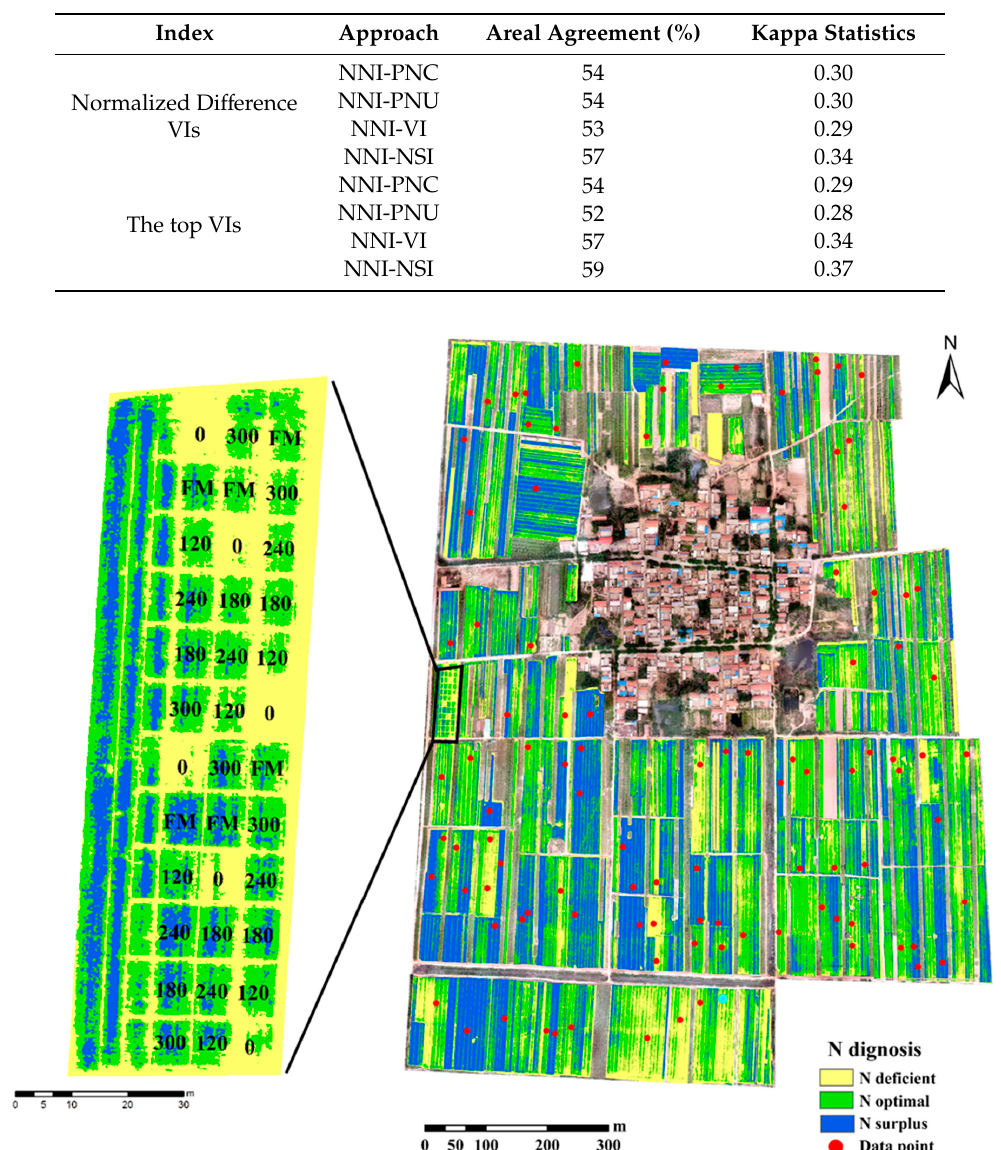
Table 3. Areal agreement and kappa statistics for di ff erent N status diagnostic approaches across varieties and years.